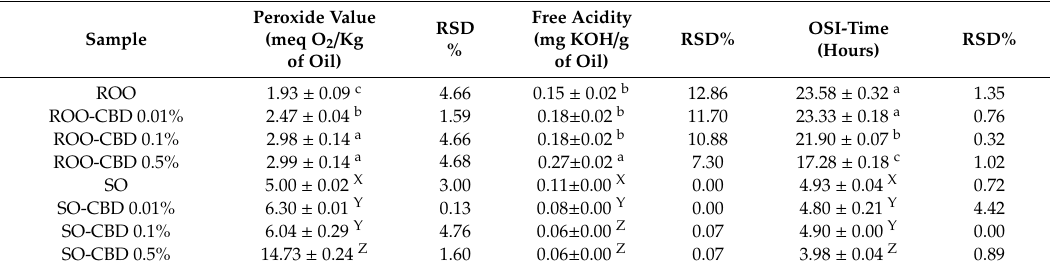
Table 1. Results of peroxide value, free acidity, and OSI-time for refined olive oil (ROO), and sunflower oil (SO) with cannabidiol (CBD) added. Data are presented as mean ± standard deviation and coe ffi cient of variation (RSD%).